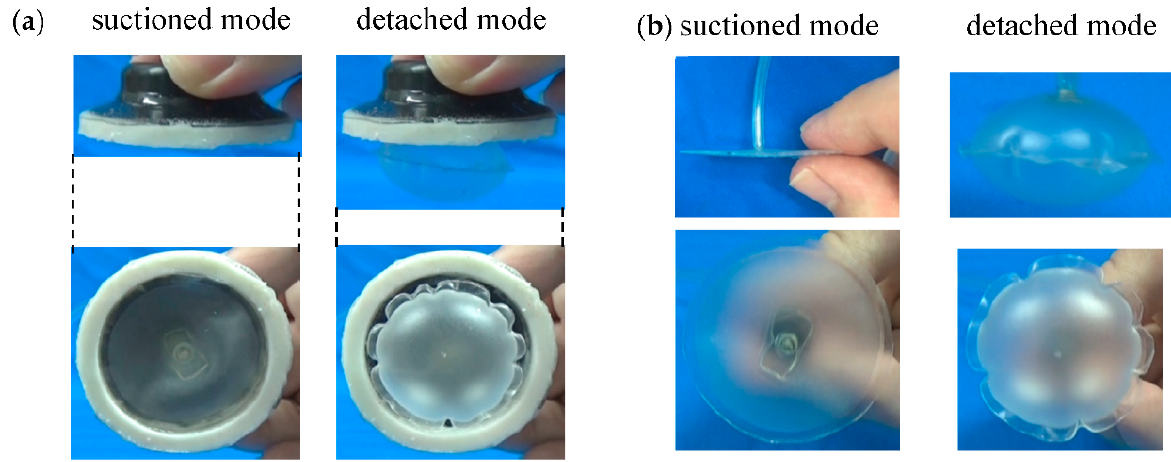
Figure 3. Fabrication process: ( a ) supporting force in the perpendicular and shearing determined by the sticky force of the gel ring and the suction force; ( b ) cross-sectional view of the release balloon in the unpressurized state; ( c ) combina- tion of the gel ring and a release balloon to a holder.